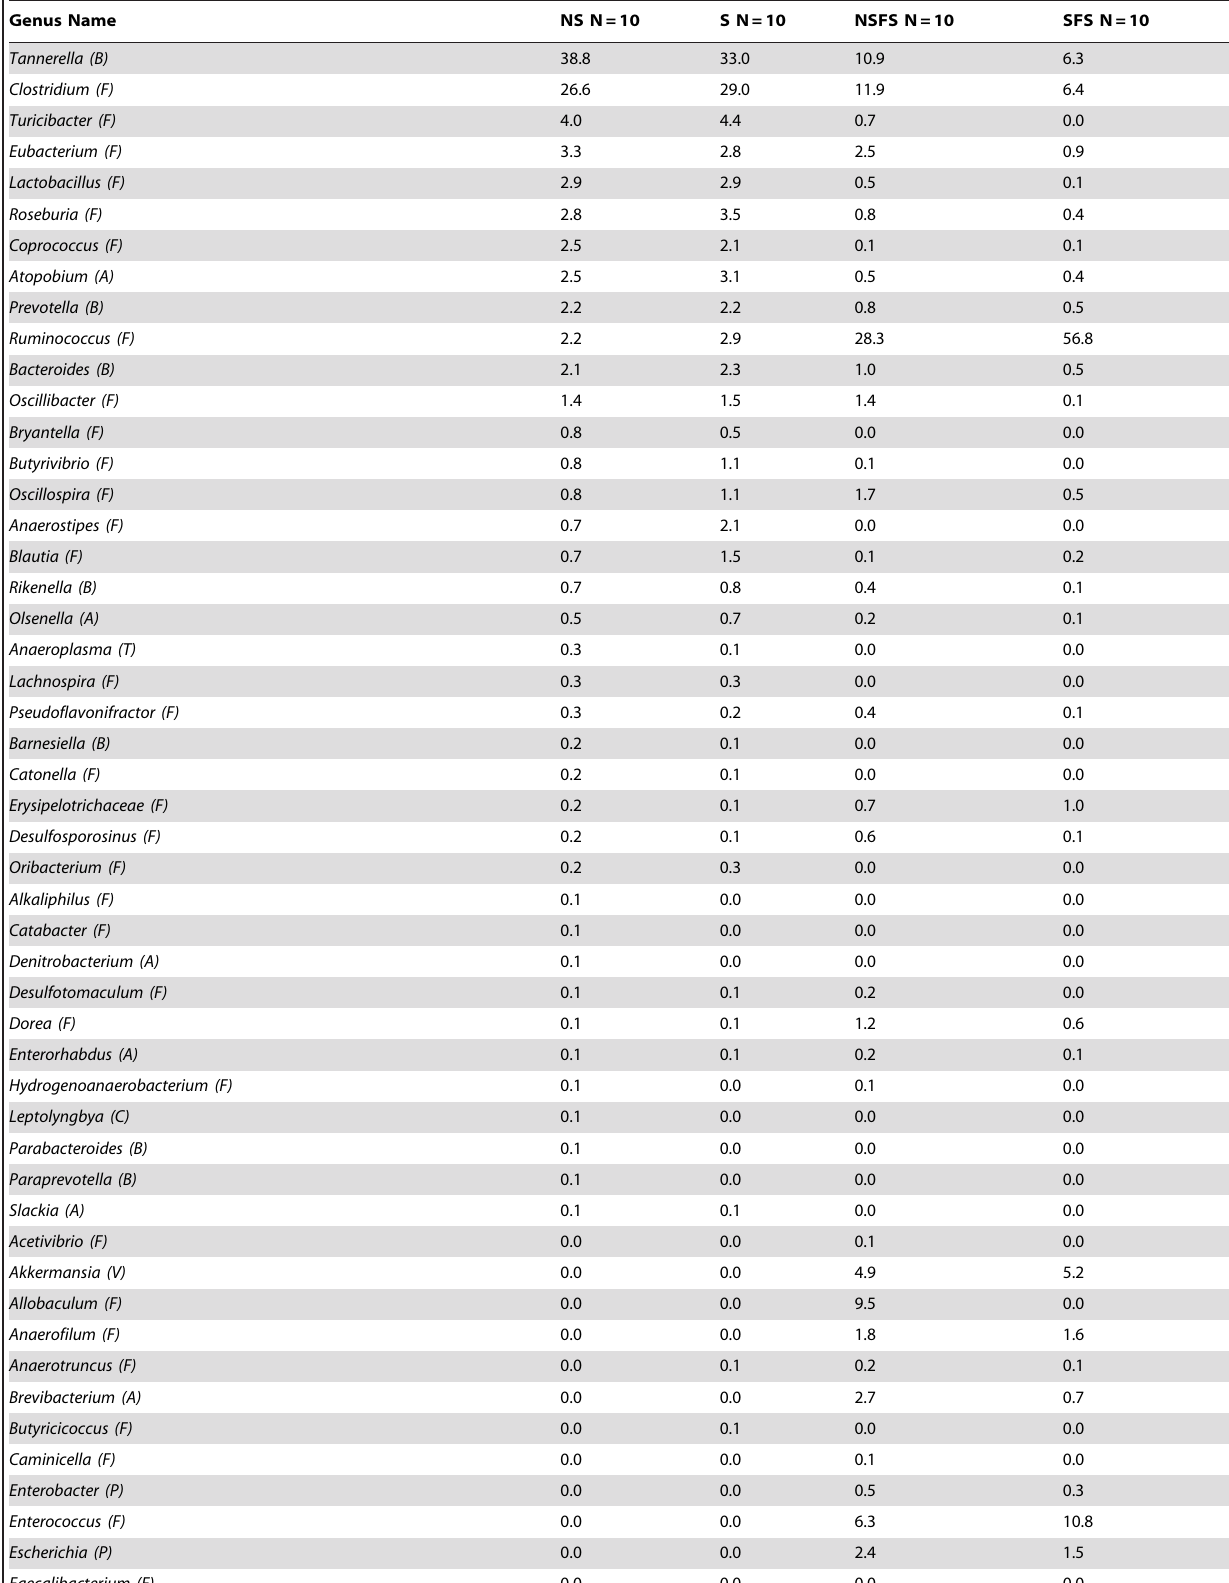
Table 6. Percent average abundance of taxon at the Genus